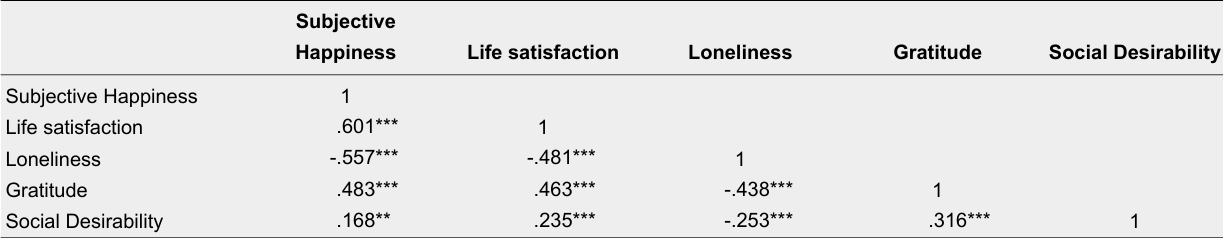
Correlations for all